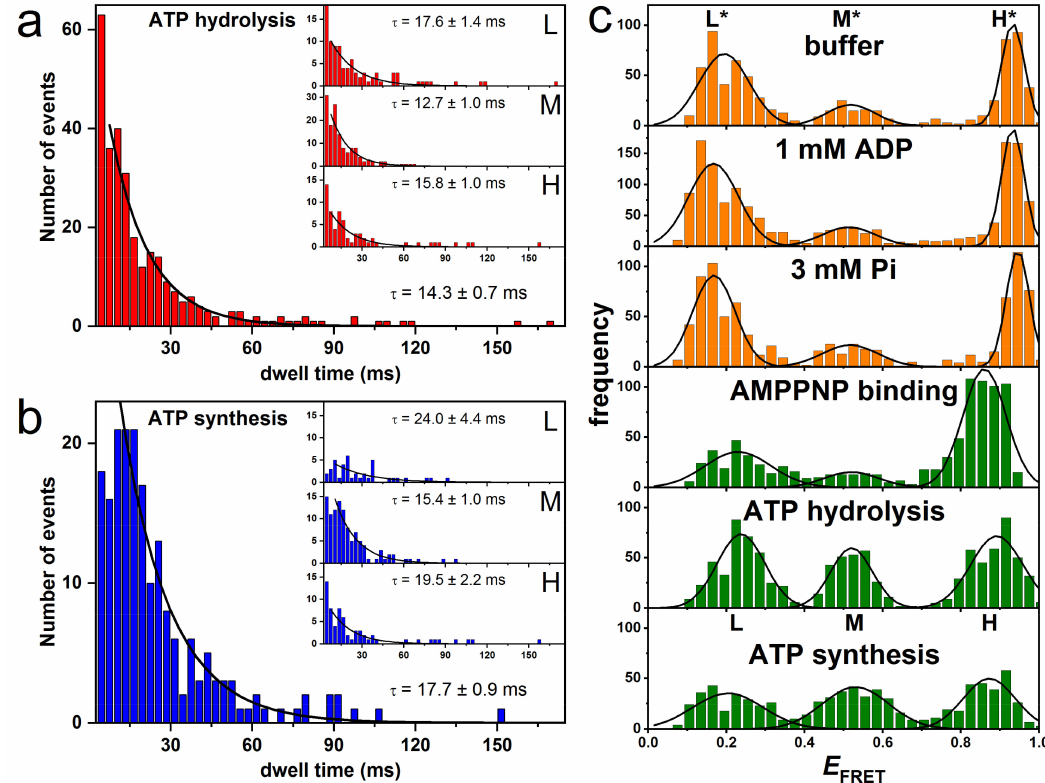
Figure 4. FRET histograms and dwell time histograms of subunit ε rotation in single FRET-labeled EcF O F 1 during catalysis. ( a ) Dwell time histogram for all FRET levels during ATP hydrolysis. The insets show the individual dwell times for each of the three FRET levels. ( b ) Dwell time histogram for all FRET levels during ATP synthesis. The insets show the individual dwell times for each of the three FRET levels. ( c ) FRET histograms showing the three FRET levels L*, M*, H* (orange), and levels L, M, H (green) from measurements at different conditions at pH 8. See text for details. (Modified from